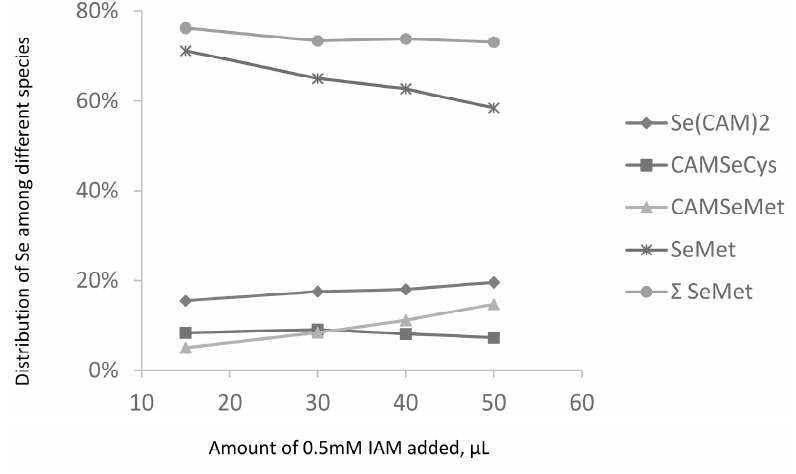
Figure 5. Influence of the derivatization conditions on relative intensity of proteolytic digestion products.